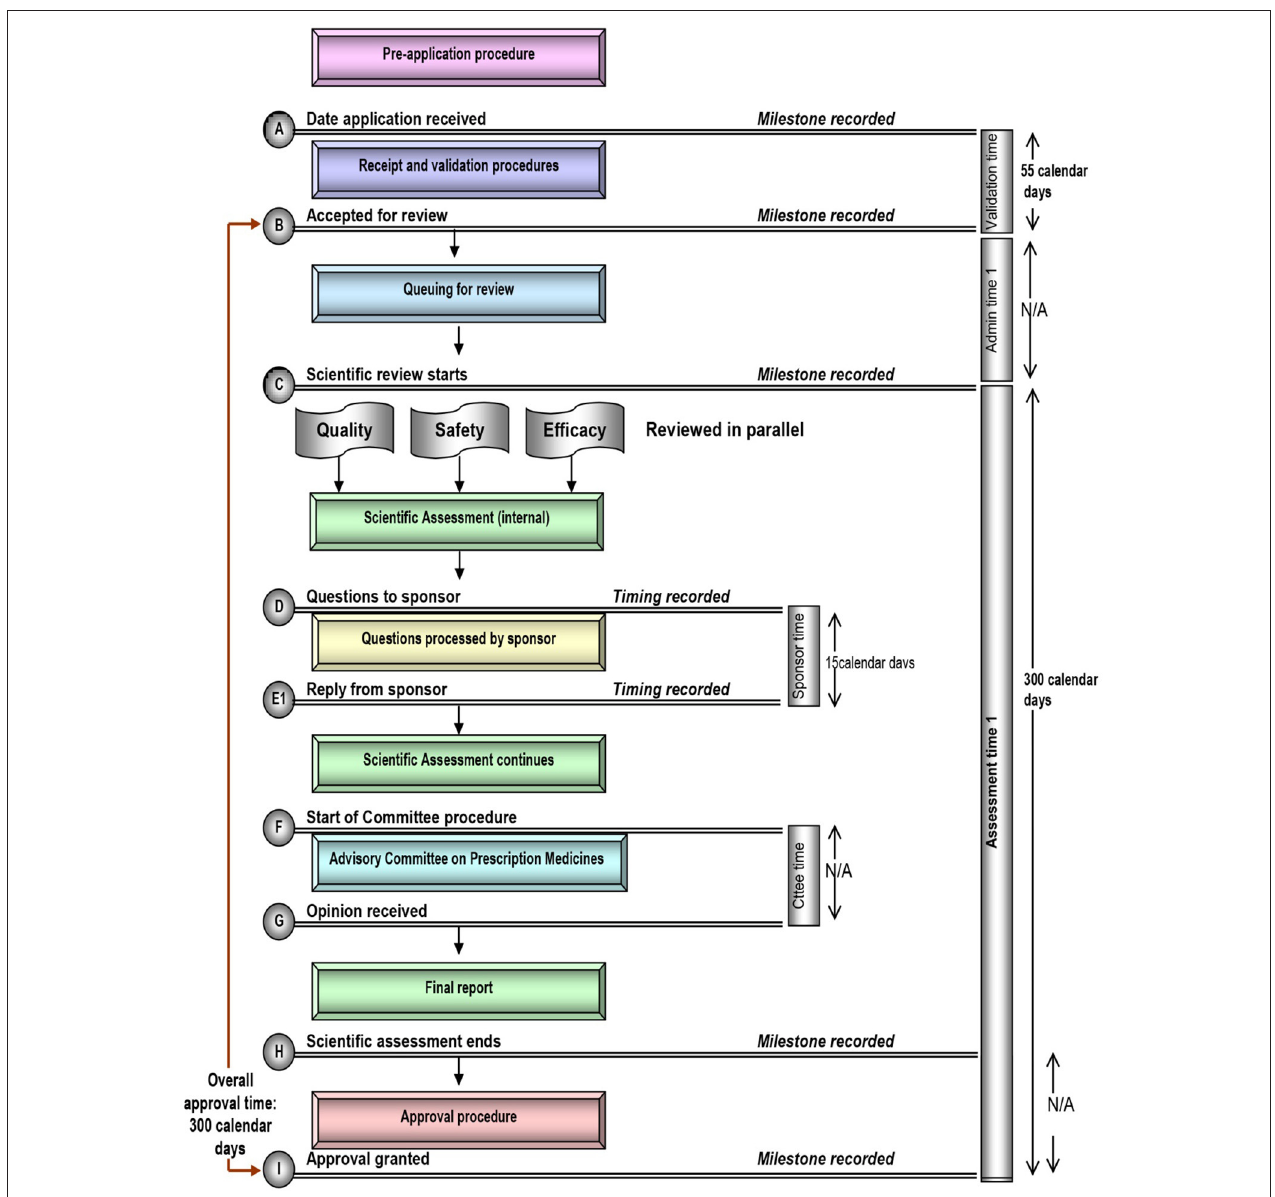
FIGURE 3 | Registration process map for